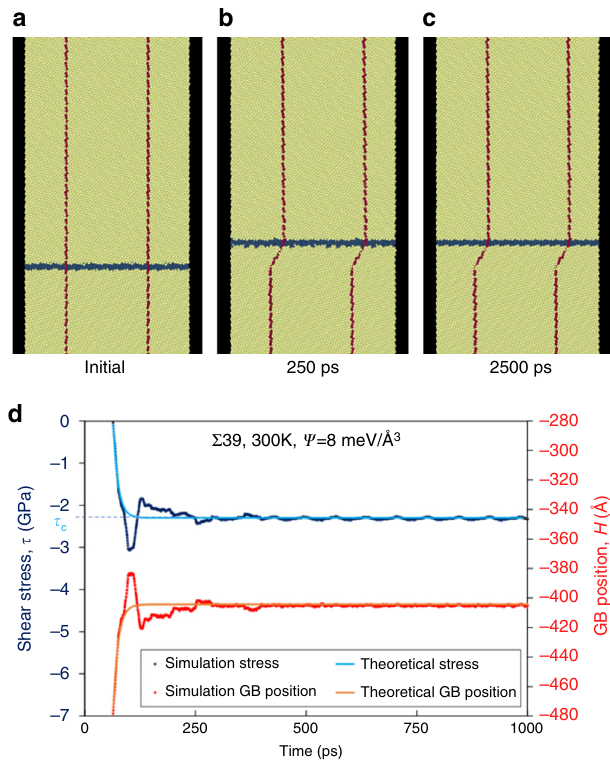
Fig. 6 Shear-coupling in a symmetric tilt GB with fi xed ends. a – c Time sequence of a bicrystal simulation identical to that in Fig. 5 except that the top and bottom surface of the simulation cell are fi xed (do not translate). d Shear stress τ and GB position H from the same simulation, compared with Eq. (7) (theoretical stress) and (8) (theoretical GB position) from the single-mode migration model, using measured values of mobility, β , and Ψ